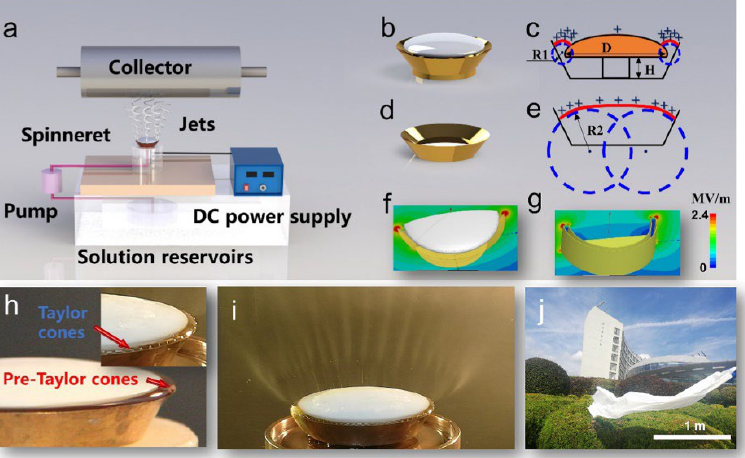
Figure 5. Mushroom-electrospinning process: ( a ) apparatus, ( b ) spinneret, ( c ) surface curvature and charge distribution on spinneret, ( d ) uncovered spinneret, ( e ) surface curvature and surface charge distribution of the uncovered spinneret. Concentrated electric field state of ( f ) the spinneret and ( g ) the uncovered spinneret. ( h ) Digital photograph of spinneret filling with solutions; the inset picture is photo of an annular array of Taylor cones under external electric fields. ( i ) Photo of multiple jets during electrospinning. ( j ) Resulting large-scale nanofiber membranes without any substrate via mushroom-electrospinning. Reproduced from [58] with the permission of Elsevier.